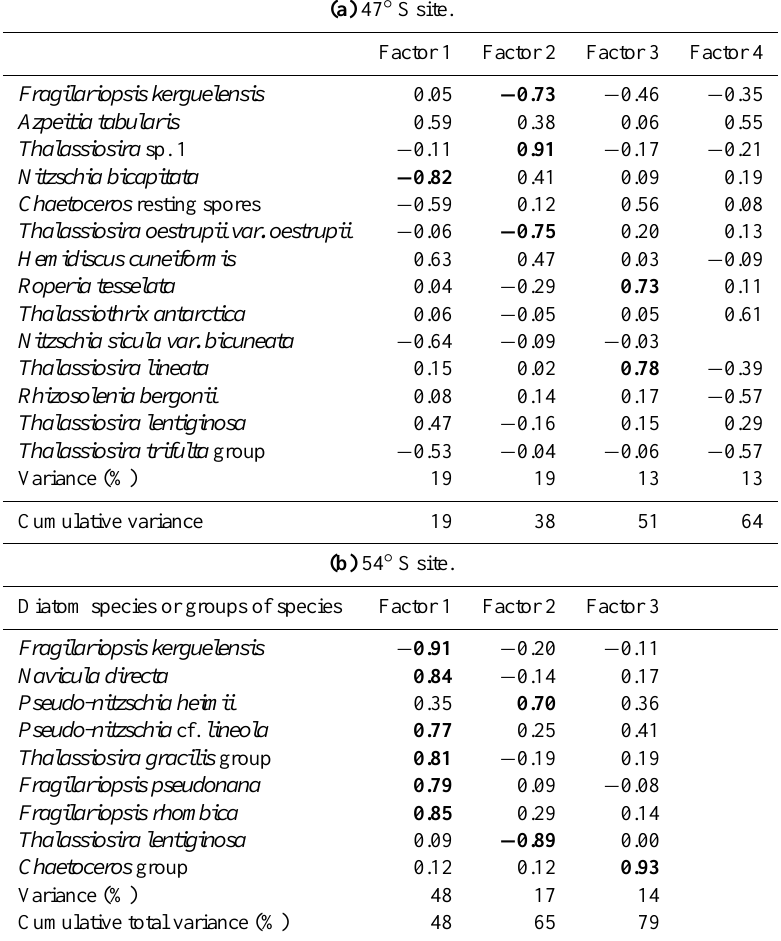
Bold values highlight the taxa that define each